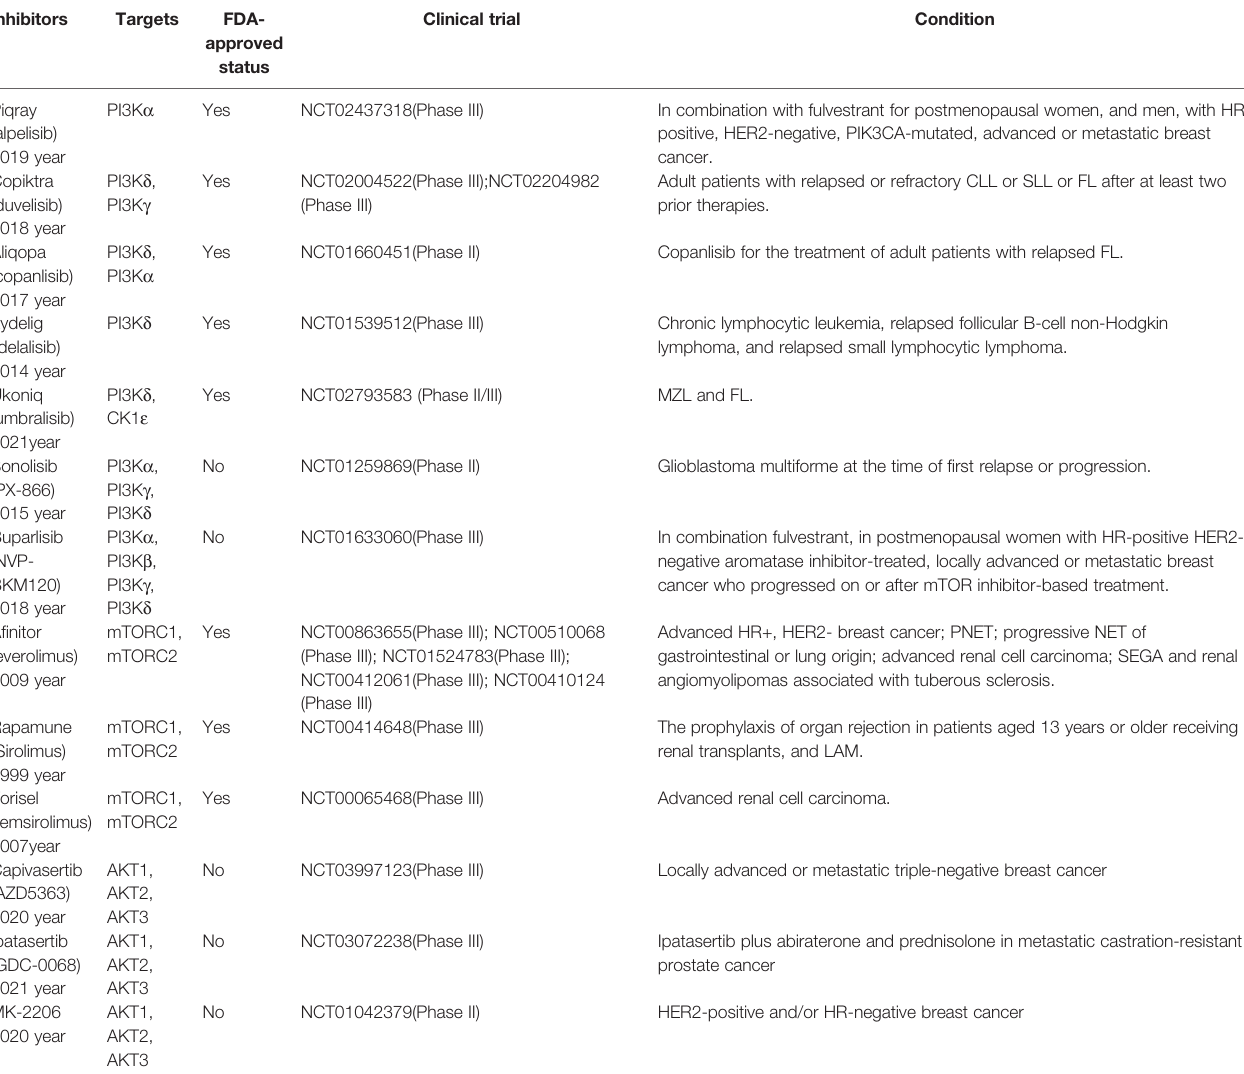
TABLE 1 | PI3K/AKT/mTOR pathway inhibitors. Inhibitors Targets FDA- Clinical trial approved status